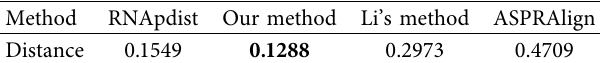
Table 6: The Pearson correlation efficiency between the cluster analysis graphs generated by the different methods and those generated by MEGA